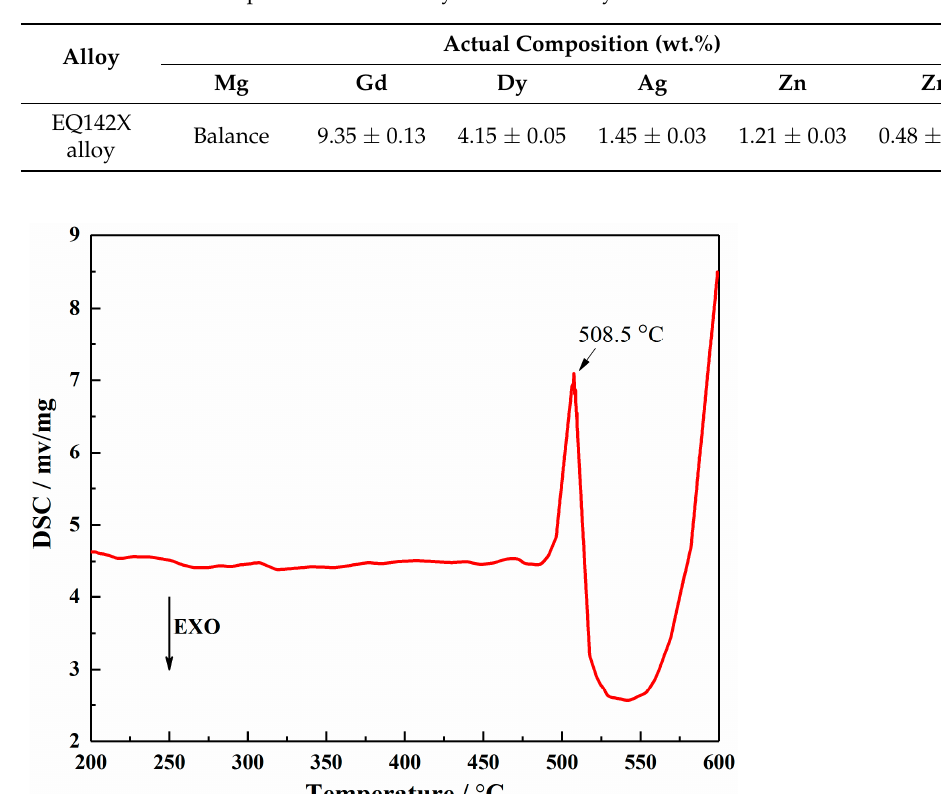
Table 1. Chemical compositions of the alloys determined by ICP-AES.